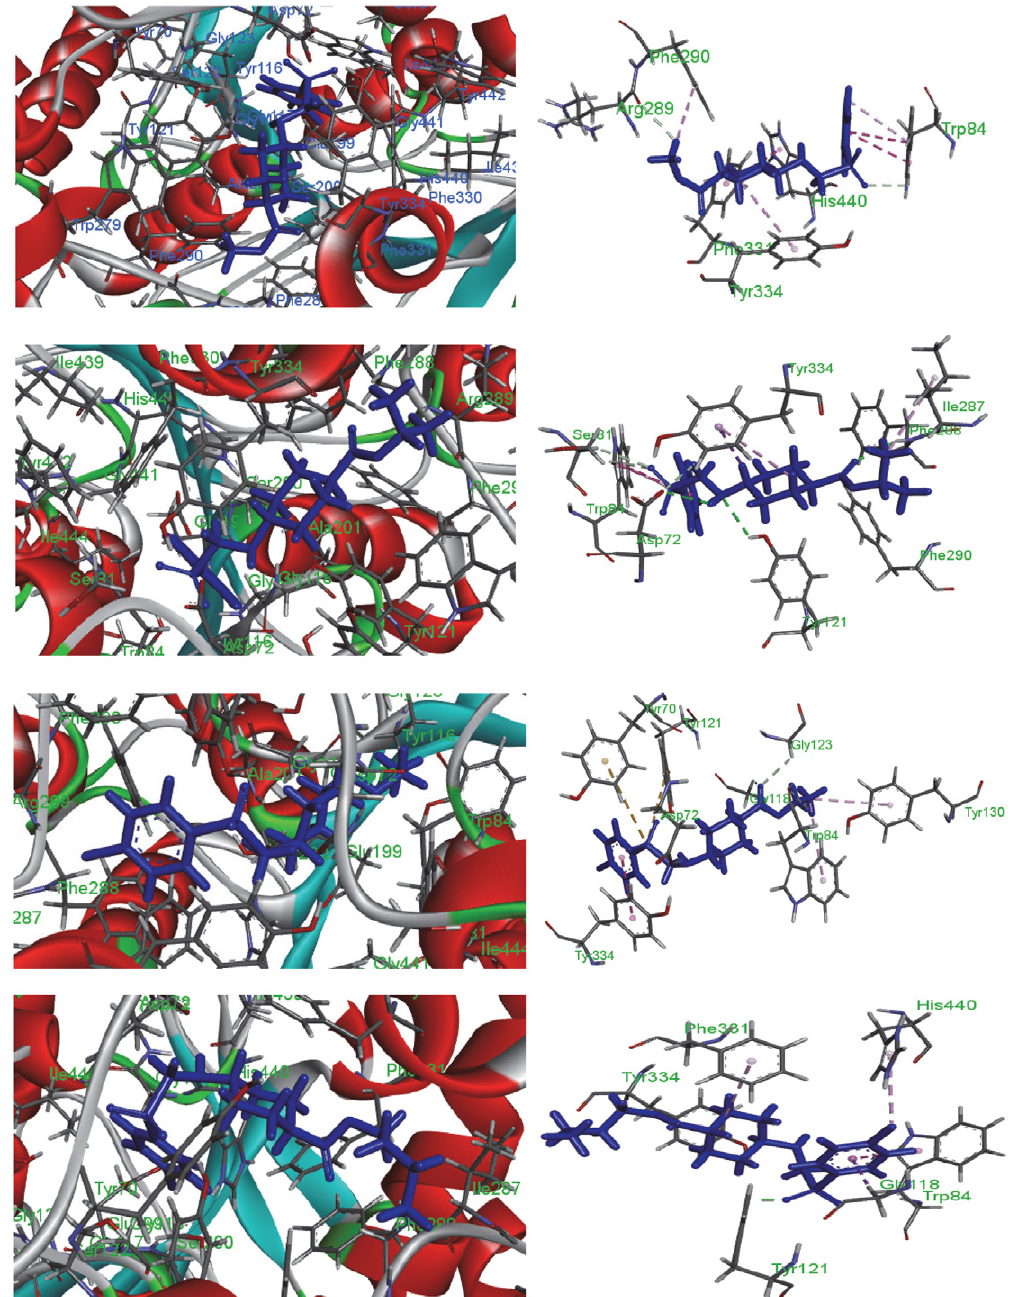
Figure 4. Best docking-poses of the synthesized compounds in the binding site of 1EVE